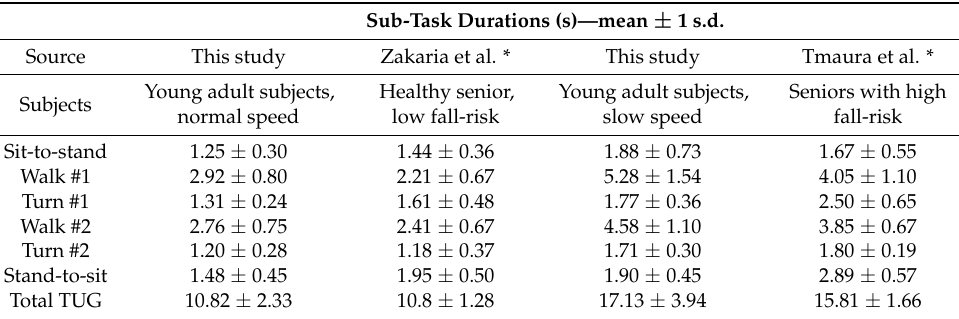
Table 1. Comparison of normal and slow TUG sub-task times with other